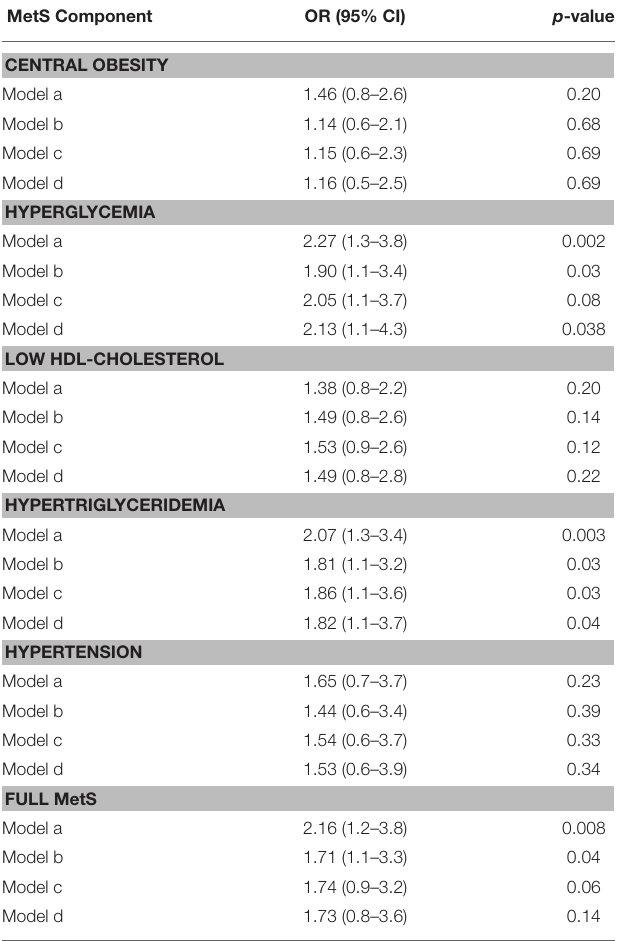
TABLE 3 | Odds of full MetS and its components at 1 st Trimester among Saudi pregnant women. MetS Component p